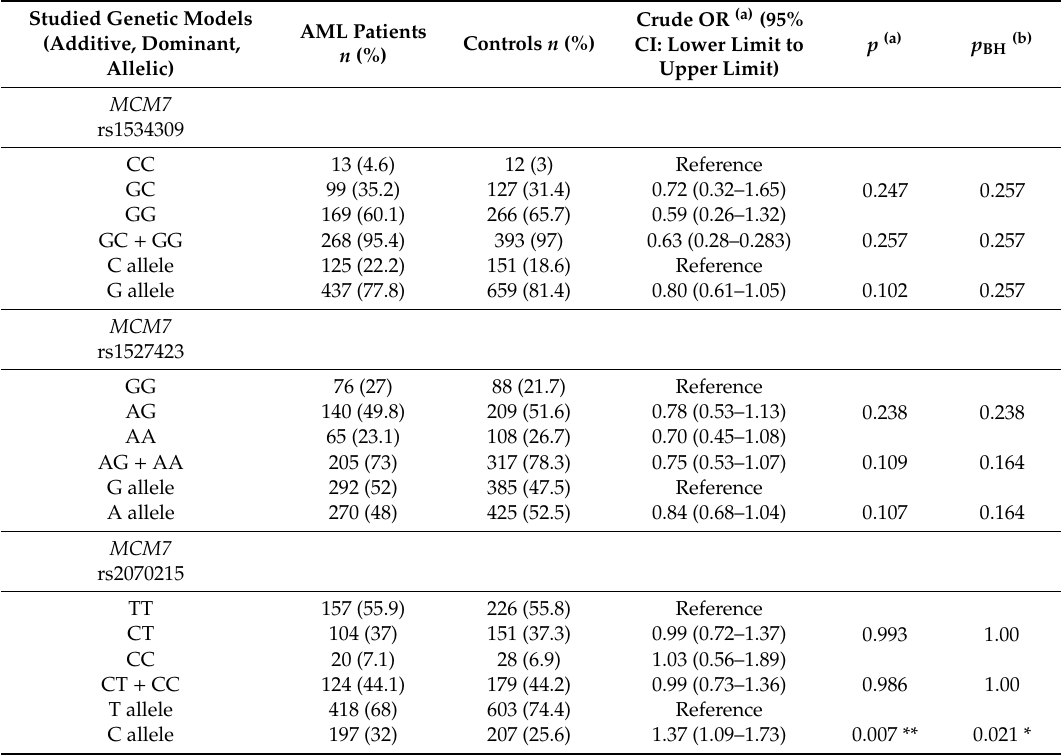
Table 1. Genotypes and alleles